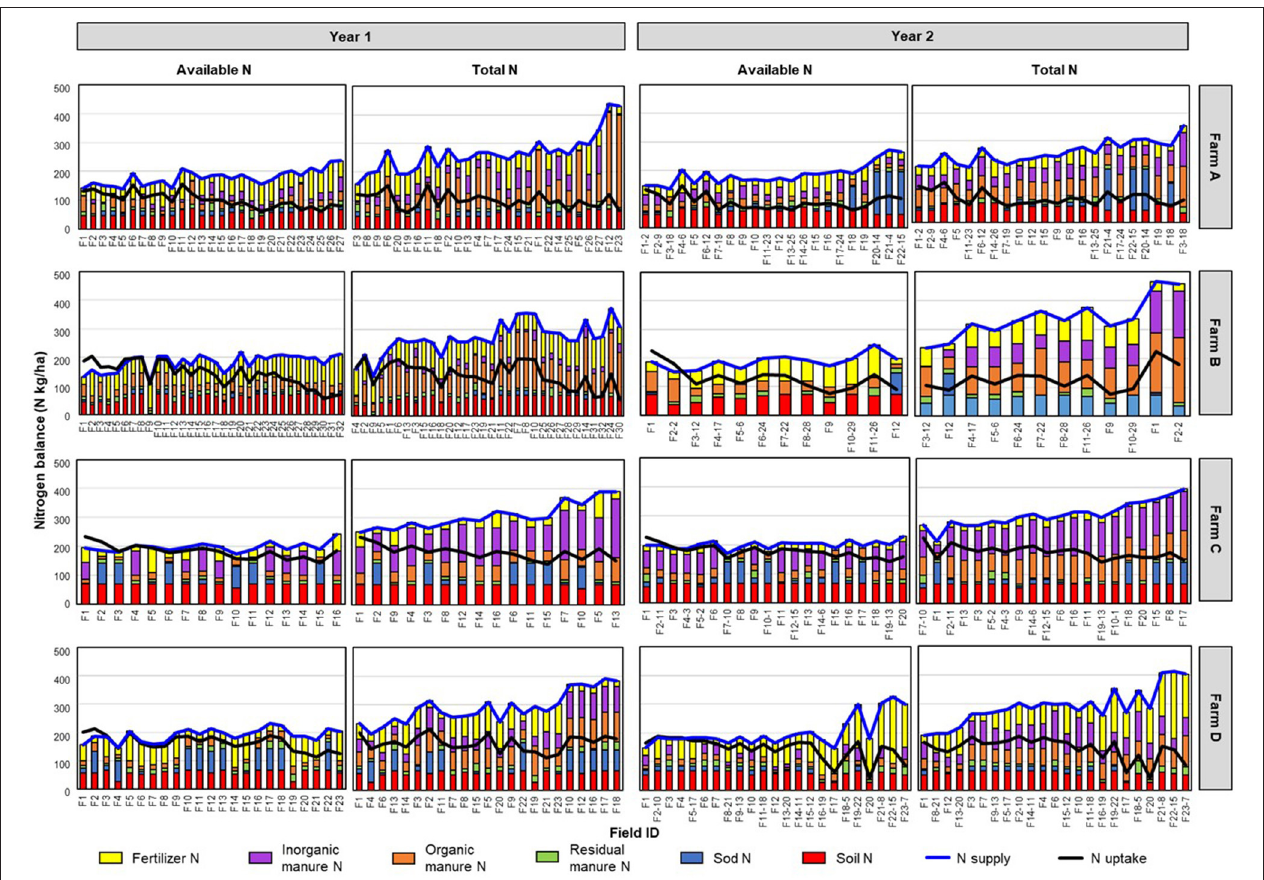
FIGURE 3 | Total and available nitrogen (N) balance are shown as a difference between nitrogen (N) demand and N supply with details of supply contributors for all corn silage fields of four farms in northern New York (A-D) for 2